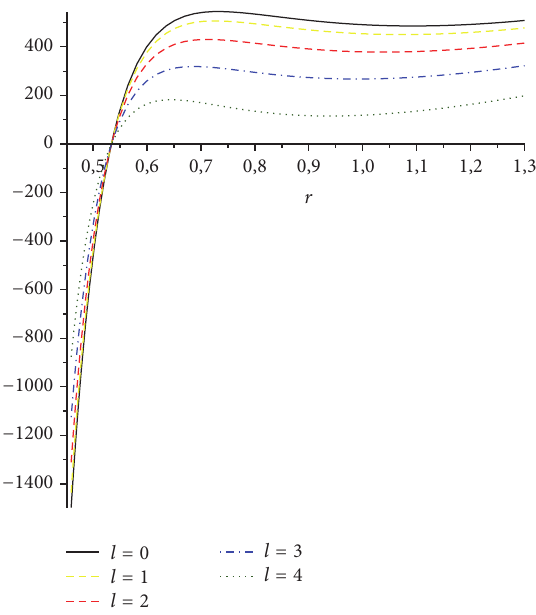
Figure 2: The potential 𝑉 in function of the radius for values 𝑙 = 0 (solid thick line), 𝑙 = 1 (long-dashed line), 𝑙 = 2 (dashed line), 𝑙 = 3 (dot-dashed line), and 𝑙 = 4 (dotted line) for the fixed values of 𝛼 0 = 2 , 𝑀 = 1 , and 𝜇 = 0 .